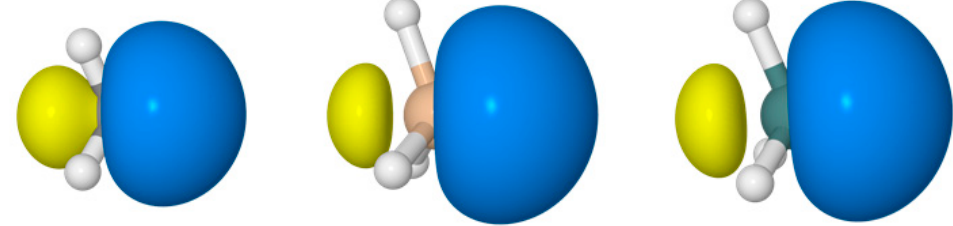
Figure 1. Pre-orthogonal bonding hybrids for CH 4 ( left ), SiH 4 ( middle ), and GeH 4 ( right ). NHO character is found to be largely independent of the ab initio or density functional method employed, as illustrated for the 15 main group hydrides of Table 1. The p -character of the bonding hybrids is reported for a range of computational methods, for densities calculated at the single-determinantal uncorrelated (RHF), multi-determinantal correlated (SCGVB, CAS), and single-reference correlated (MP2, CCSD) levels, and with density functional theory (B3LYP), all at fixed MP2/aVTZ optimized geometries. For each hydride, the p -character varies weakly across the series of densities. Even for HBr, which exhibits the largest λ variation (from 6.82 at the RHF level to 7.81 for SCGVB), the percent p -character changes by only 1.4% (from 87.2% to 88.6%). Note specifically that the SCGVB